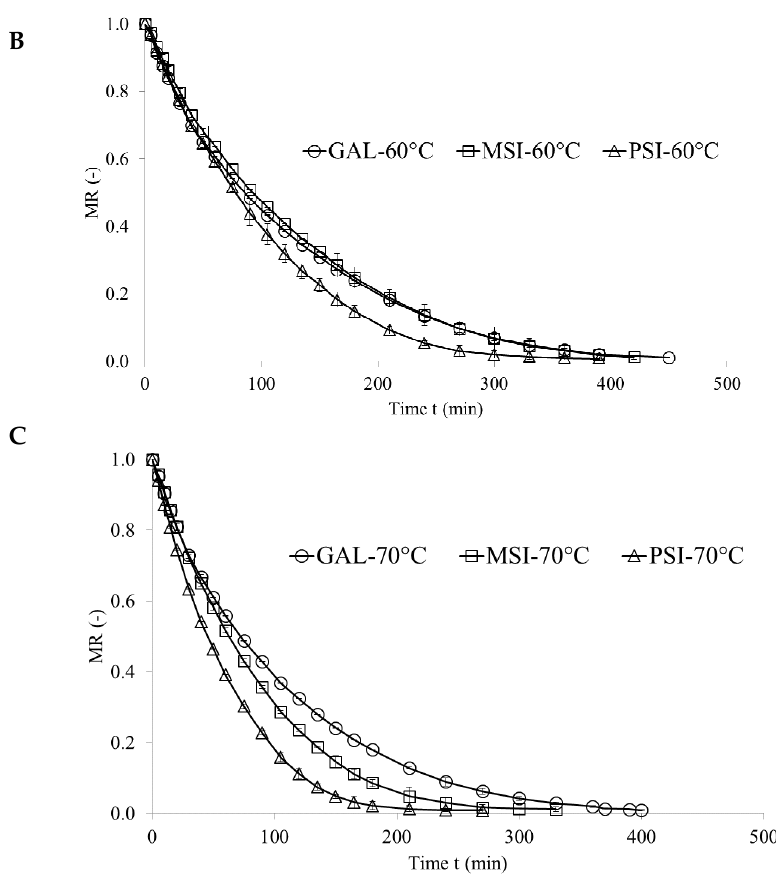
Figure 1. ( A ) Drying kinetics of jujube fruits during CD 50 °C; ( B ) Drying kinetics of jujube fruits during CD 60 °C; ( C) Drying kinetics of jujube fruits during CD 70 °C.